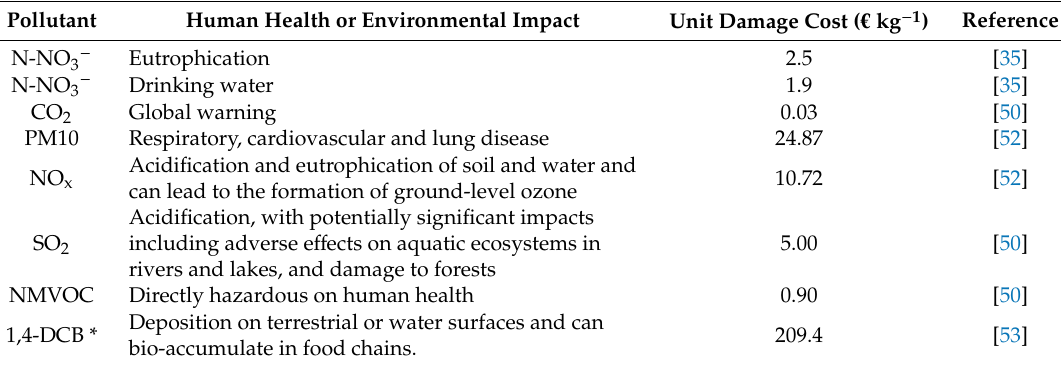
Table 2. Unit damage costs for health and environmental impacts of nitrogen in water and other pollutants in air due to fuel